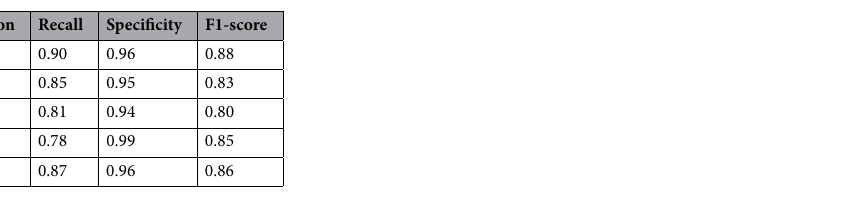
Table 3. XGBoost classification performance for each